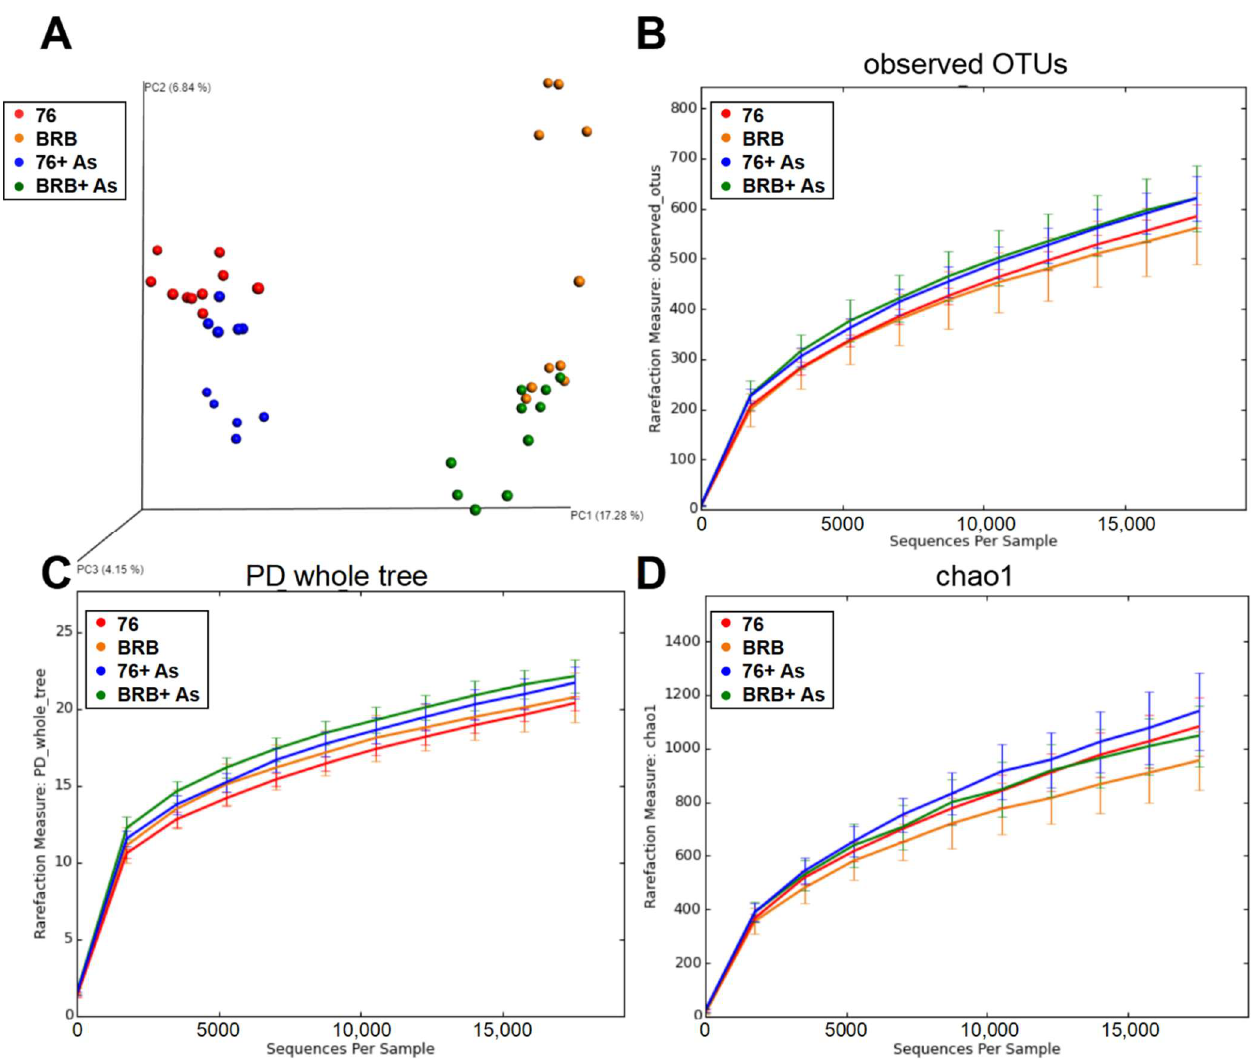
Figure 2. PCoA and alpha rarefaction analysis. ( A ) 3D PCoA plot of gut microbial communities, based on the unweighted UniFrac distance metric. Alpha rarefaction analysis using indices of observed OTUs ( B ), PD whole tree ( C ), and Chao1 ( D ).